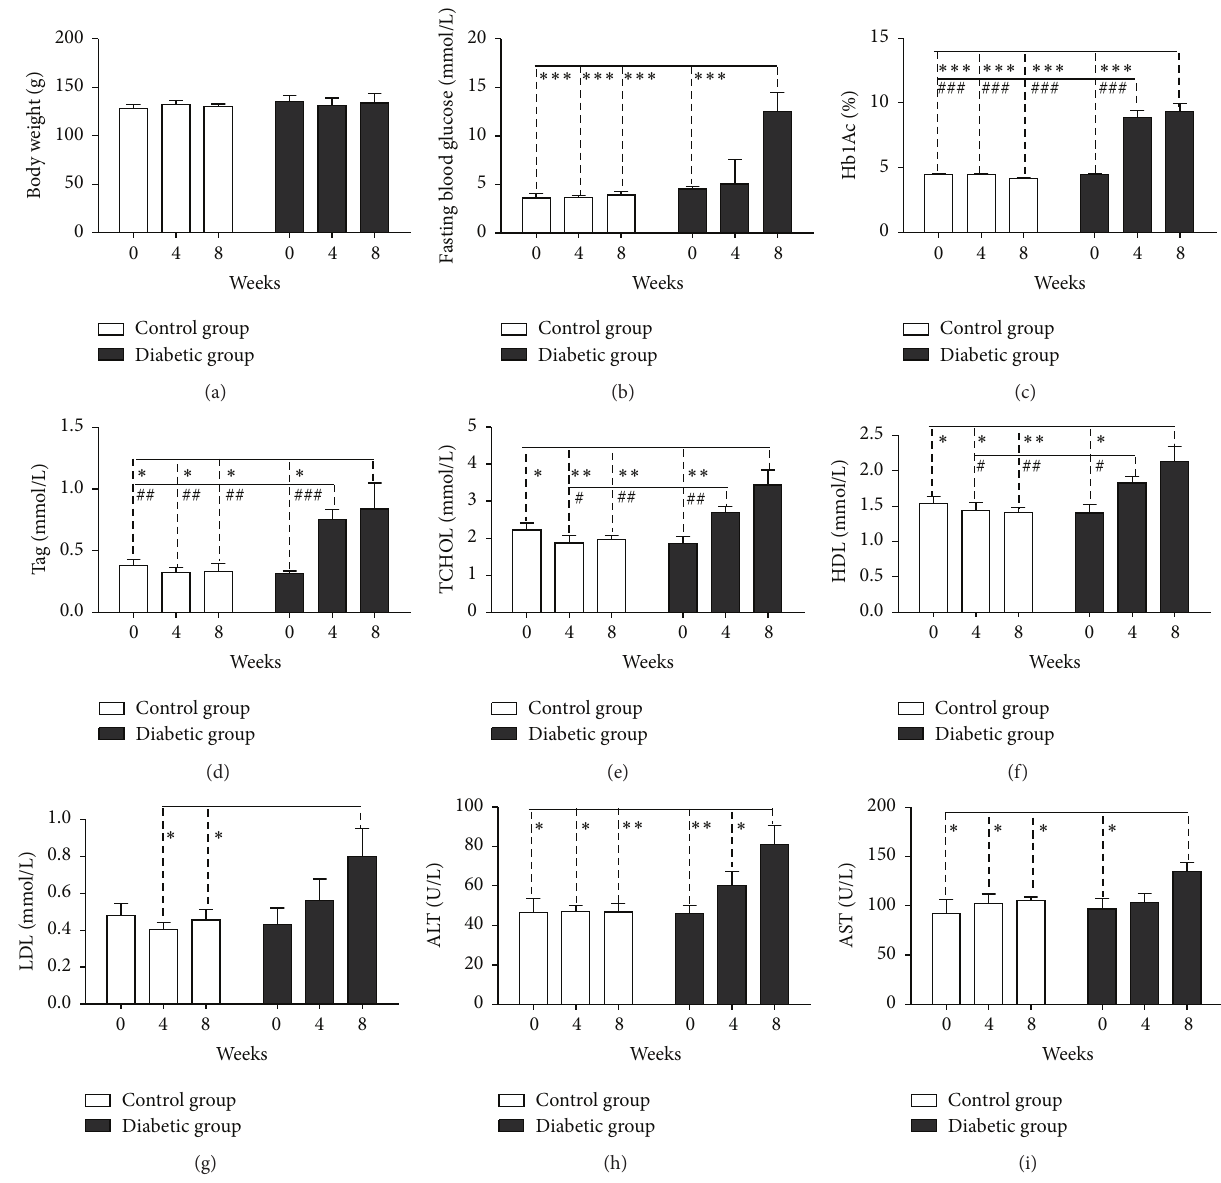
Figure 1: Biochemical parameters in healthy control tree shrews and STZ-induced diabetic tree shrews over 8 weeks. (a) Body weight; (b) plasma concentration of fasting blood glucose; (c) serum concentration of HbA1c; (d) serum concentration of triglycerides (TAG); (e) serum concentration of cholesterol (CHOL); (f) serum concentration of high-density lipoprotein cholesterol (HDL); (g) serum concentration of low-density lipoprotein cholesterol (LDL); (h) serum concentration of alanine aminotransferase (ALT); (i) serum concentration of aspartate aminotransferase (AST). 𝑛 = 6 in control group; 𝑛 = 5 in diabetic group. Significance between two groups. Control group versus 8 weeks of diabetic group: ∗ 𝑃 < 0.05 , ∗∗ 𝑃 < 0.01 , and ∗∗∗ 𝑃 < 0.001 ; control group versus 4 weeks of diabetic group: # 𝑃 < 0.05 , ## 𝑃 < 0.01 , and ### 𝑃 < 0.001